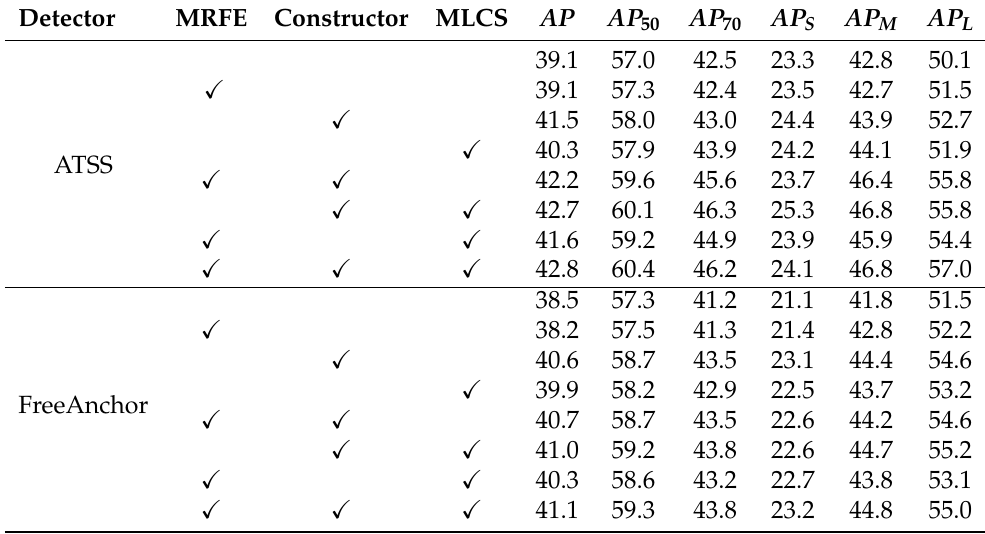
Table 3. The results of ablation experiments performed by our algorithm on ATSS and FreeAnchor. [ (cid:88) ] mean the module is added into the